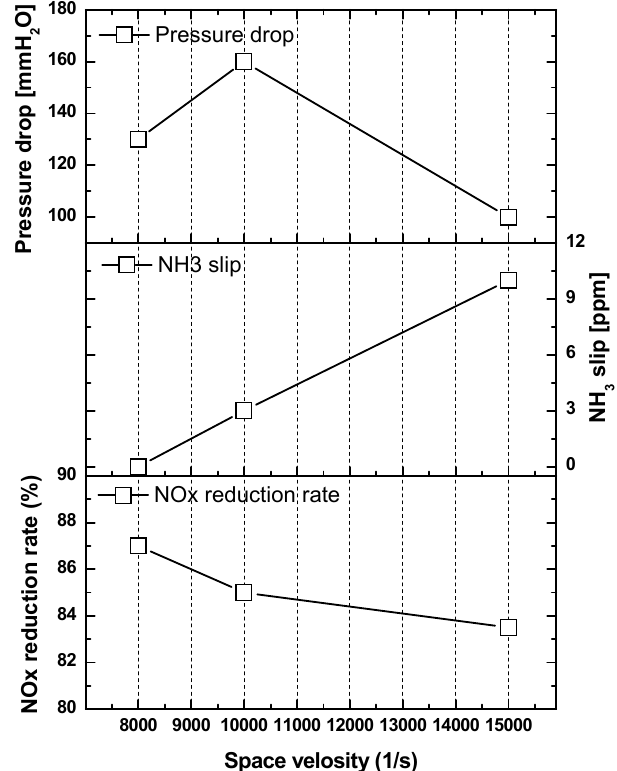
Figure 11. Characteristic of pressure decrease, NOx reduction rate, and NH 3 slip in relation to the variation in space velocity.